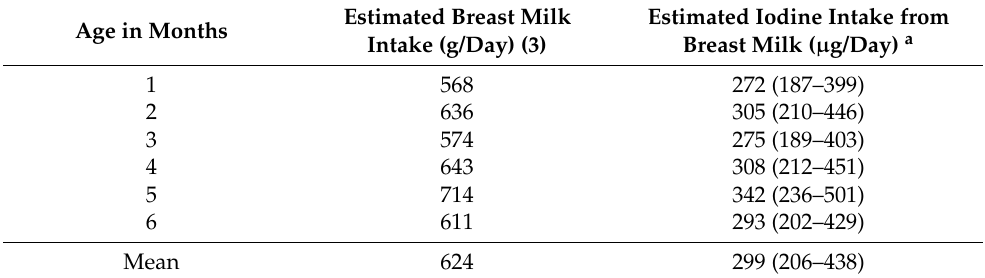
Table 3. Estimated iodine intake in age groups 1–6 months based on median (p25–p75) BMIC.